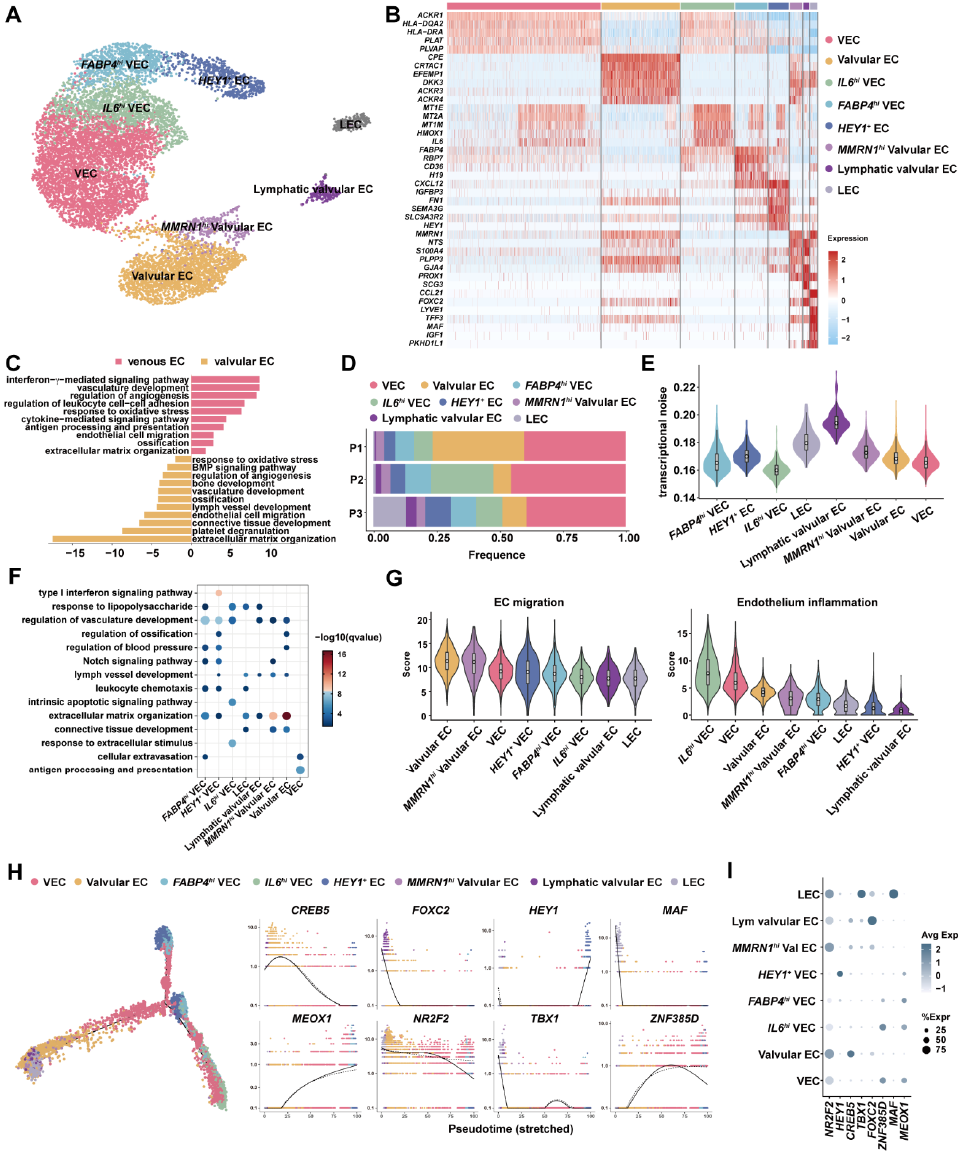
Figure 2. Endothelial cell diversity in human GSVs. ( A ) The UMAP plot of EC cell subsets. ( B ) Heatmap showing the signature genes for each EC subset. ( C ) Gene ontology enrichment of differential expressed gene between venous ECs and valvular ECs. Only upregulated genes were selected for analysis. ( D ) EC cell subset ratio in each patient. This result suggested that IL6 hi VECs were enriched in patients complicated with hypertension and type 2 diabetes. ( E ) Transcriptional noise analysis showing that IL6 hi VECs had the least heterogenous expression. ( F ) Functional enrich- ment of highly expressed genes for each EC subset. Results infer that valvular EC subsets possessed profound signatures in extracellular matrix organization, whereas venous EC subsets were involved in cell infiltration. ( G ) Comparison of EC migration ability and endothelium proinflammatory score among EC cell subsets. ( H , I ) Inference of EC cell subset developmental connection by pseudo-time trajectory analysis. Valvular EC subsets and EC subsets exhibit distinct cell fates. The mast regulators for venous fate ( NR2F2 ), arterial fate ( HEY1 ), panvalvular fate ( CREB5 ), vascular bed differentiation ( MEOX1 ), venous EC fate ( ZNF385D ), lymphatic fate ( TBX1 ) and lymphatic valvular fate ( FOXC2 ) are plotted along trajectories and in cell